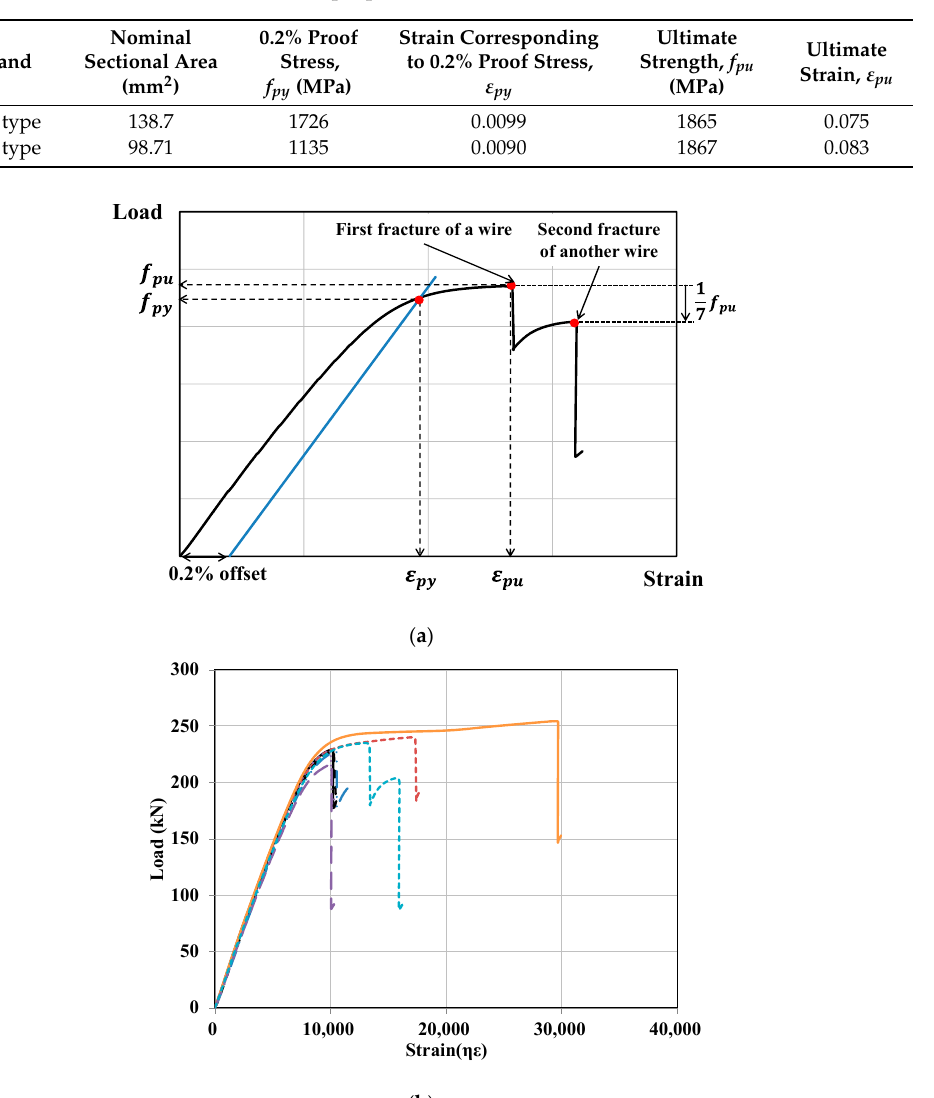
Figure 10. ( a ) Test setup, ( b ) failure of non-corroded strand, and ( c ) failure of corroded strand. Table 1. Mechanical properties of the non-corroded strands.